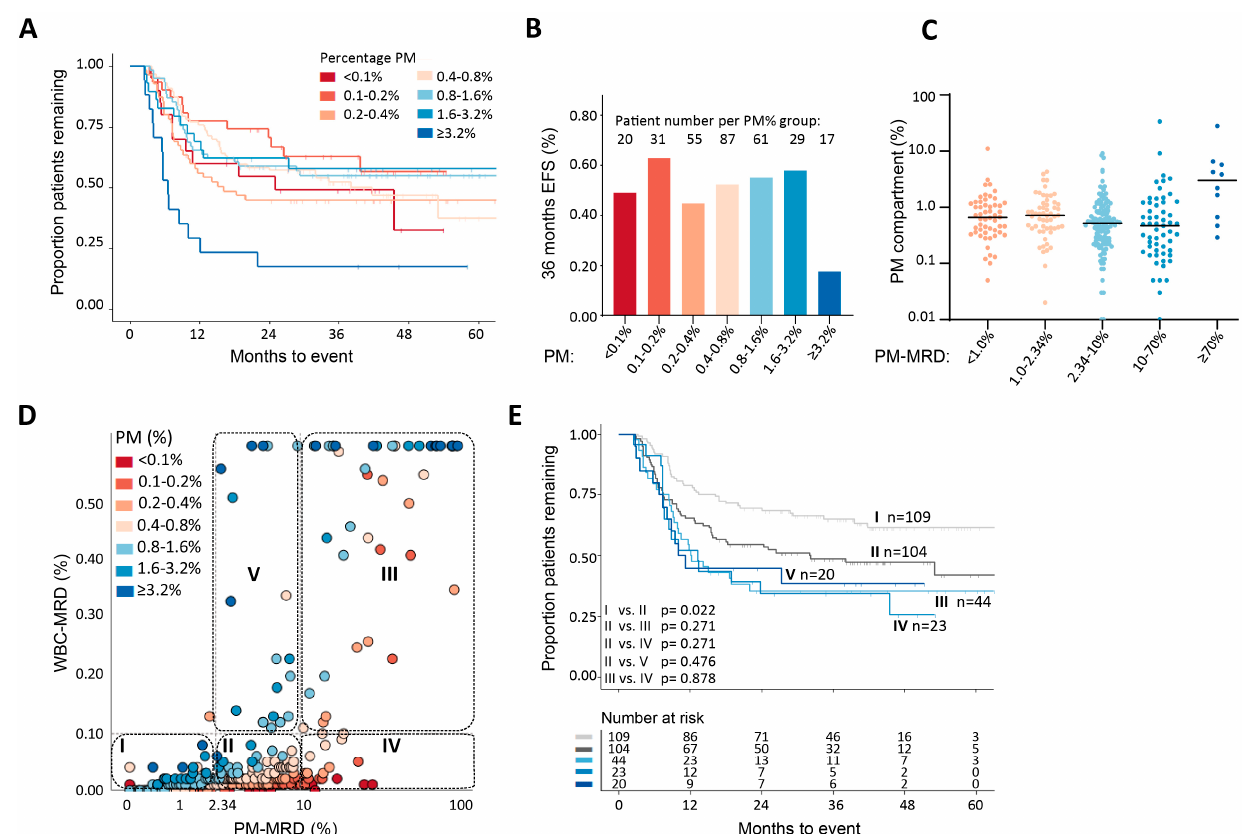
Figure 4. Role of the percentage of the whole (AML + normal) PM compartment (“PM%”) in the combined prognostic value of PM-MRD and WBC-MRD. The PM% in the total patient group was subdivided as shown in A (inset). ( A ) The Kaplan–Meier analysis showed that there was no consistent difference in EFS between patients in different PM% groups, except for the group with PM% ≥ 3.2% (lower EFS), but in this group, 4/17 samples were from patients who had already officially relapsed at the time of sampling. ( B ) EFS at 36 months in the different PM% groups. No consistent increase or decrease in EFS was seen with an increasing PM%, except in the PM ≥ 3.2% sub-group. ( C ) Distribution of PM% within different PM-MRD regions. Large heterogeneity of PM% was found across the whole range of PM-MRD in the group of patients as a whole. ( D ) Relationship between WBC-MRD and PM-MRD. The correlation between PM-MRD and WBC-MRD was moderate (r = 0.737, p < 0.001). In sub-group IV, (very) low PM percentages (identified by the different reddish/orange colors) result in (very) low MRD values (because PM-MRD × PM% will be <0.1), despite the high, prognostically unfavorable PM-MRD values ( ≥ 10). When no correction of WBC-MRD for LAIP coverage at diagnosis was applied (so WBC-MRD not corrected ), the results were only altered slightly. This is further explained in Supplementary Text S1. These results confirm the strength of the prognostic impact of the PM-MRD ≥ 10% group. ( E ) Analysis of EFS in sub-groups defined by PM-MRD cut-off values of 2.43% and 10% and by a WBC-MRD cut-off value of 0.1%. Sub-group V is considered in Texts S1 and S2. The cytogenetic and molecular characteristics of the five subgroups can be found in Table